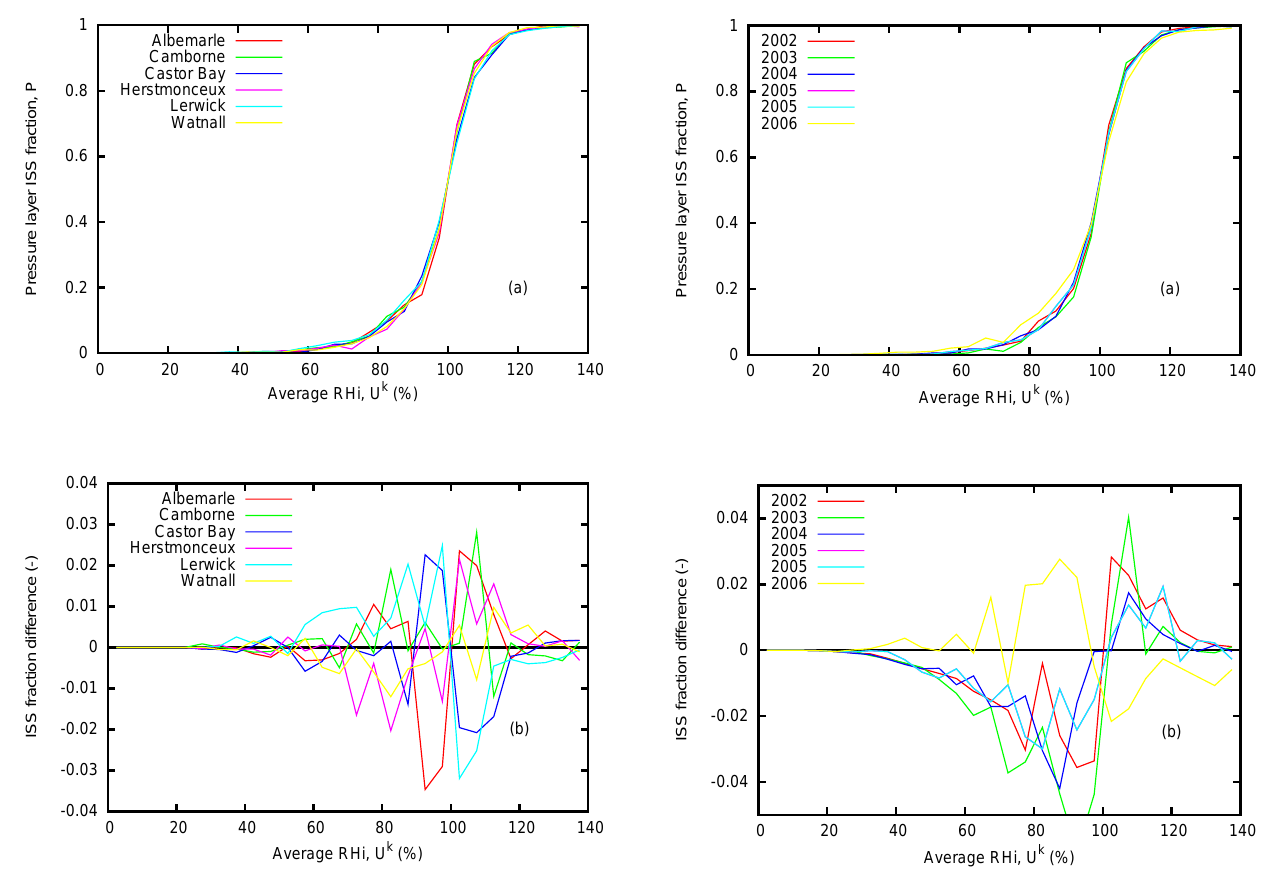
Fig. 8. The relationship between average RHi and the ISS fraction for the 250–300hPa pressure layer is shown. Panel (a) shows the s-shaped relationships and panel (b) shows the difference between each calender year curve and the British Isles mean. These data are from six high resolution radiosonde launch stations within the British Isles (January 2002–December 2006).